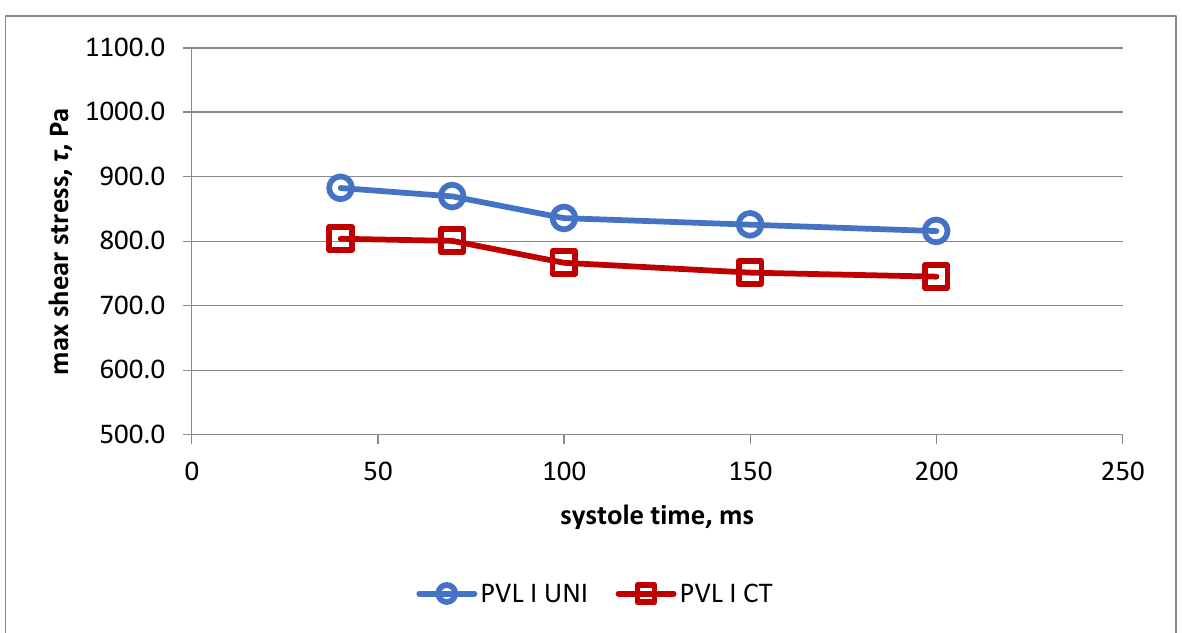
Figure 4. Values of maximal wall shear stress in universal model (UNI) and real-life model (CT) for PVL model I.